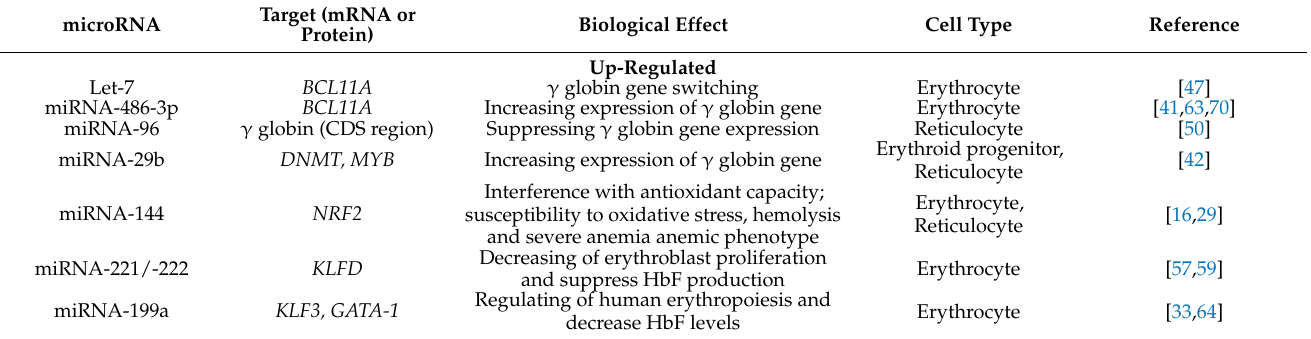
Table 1. miRNA expression and its targeted gene associations with different biological effect in SCD. microRNA Target (mRNA or